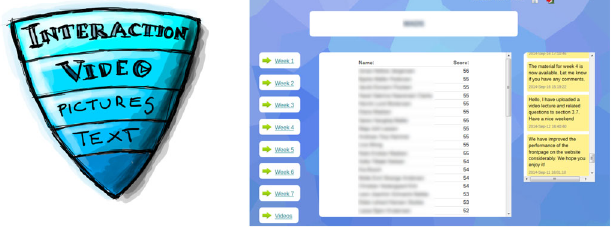
FIG. 1. Left: Content priority for StudentResearcher . Convey most of the content through interactive elements, then video format, illustrations, or text in descending order. Right: The landing page of StudentResearcher after